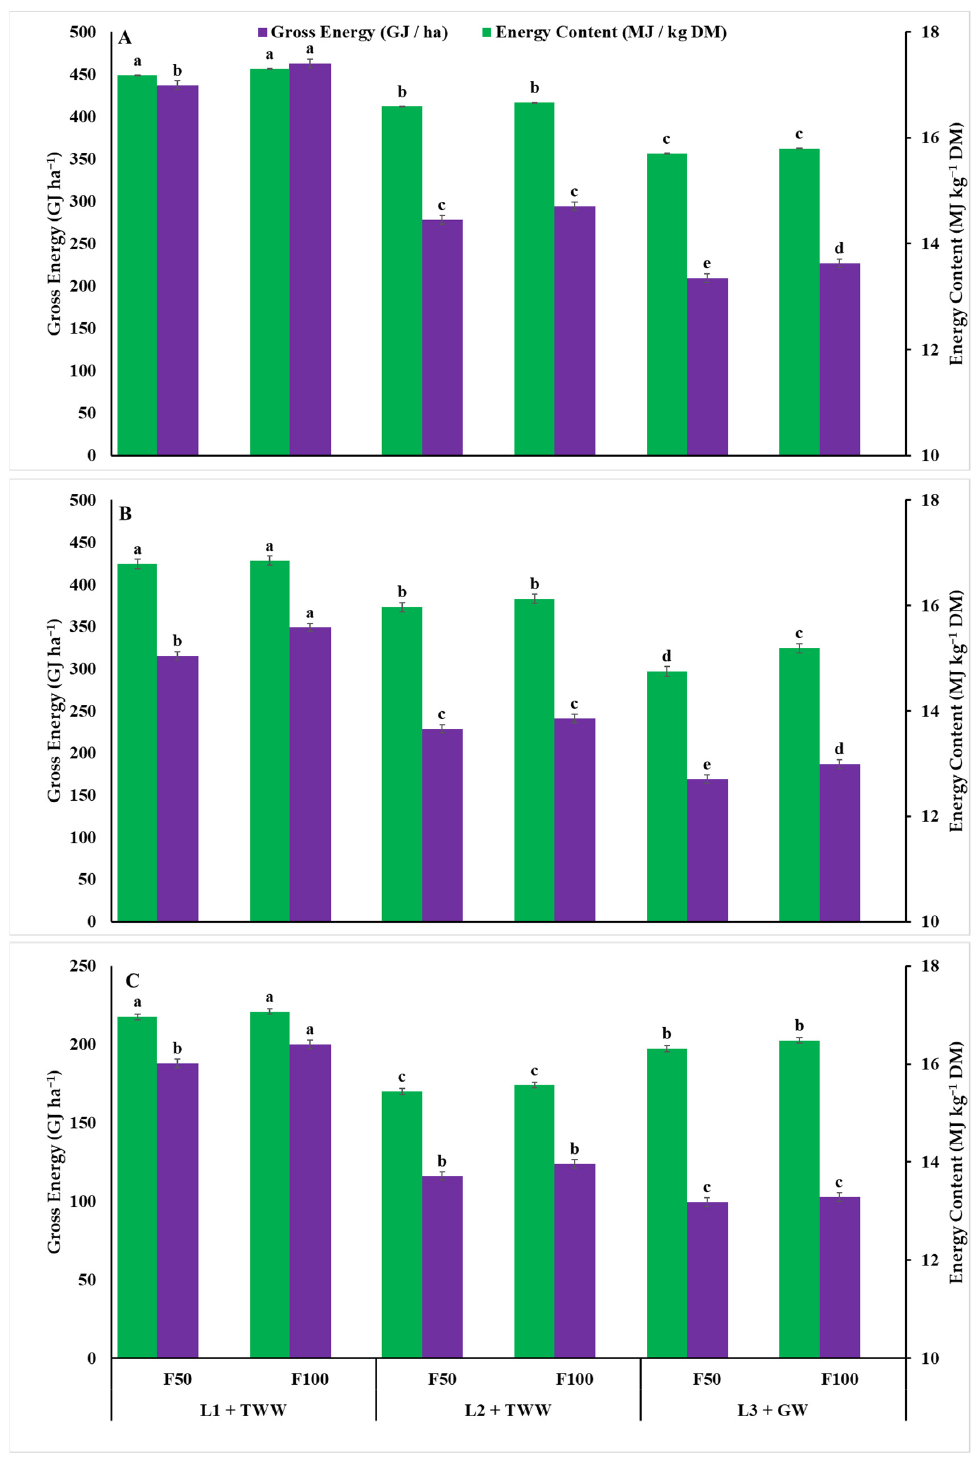
Figure 3. Interaction effects of water resources and fertilization treatments on energy traits of biomass for safflower ( A ), canola ( B ), and triticale ( C ).Old soil with treated wastewater (L1 + TWW), virgin soil with treated wastewater (L2 + TWW), virgin soil with groundwater (L3 + GW), half-dose NPK (F50), full-dose NPK (F100). Values followed by the same letter were not significantly differed for each trait.